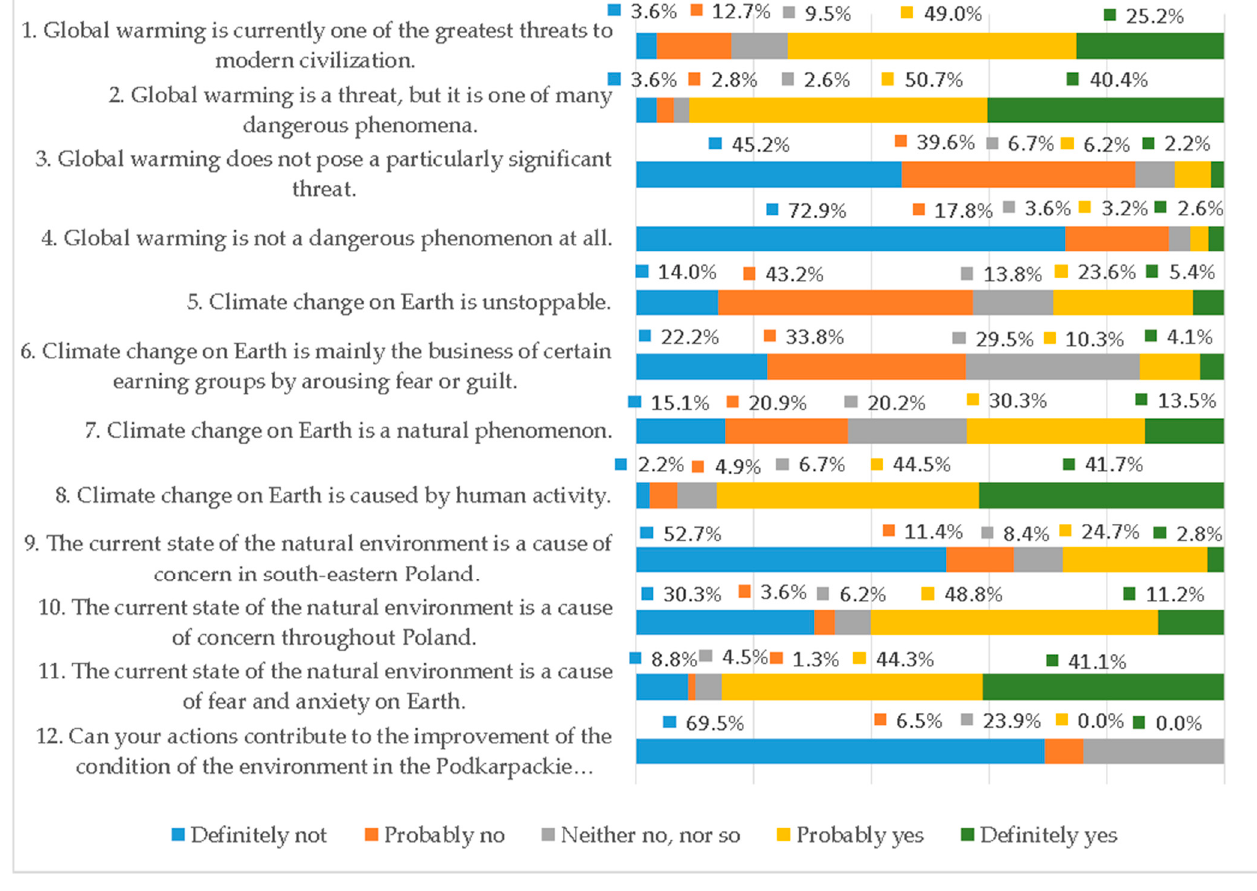
Figure 1. The structure of assessments of theses diagnosing the perception of global warming, climate change, and the quality of the natural environment by young adolescents.